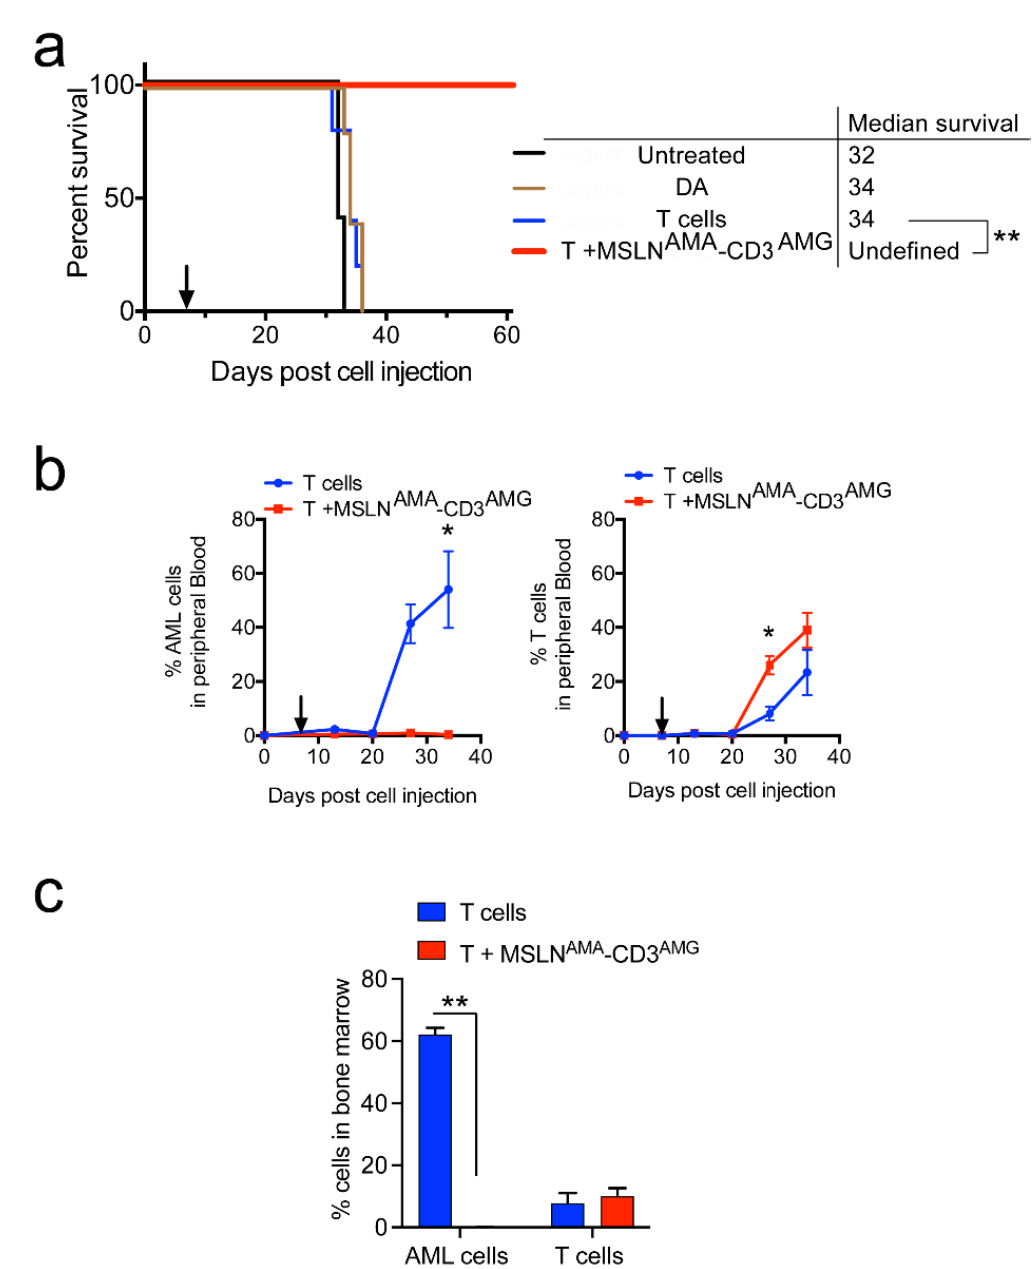
Figure 5. Confirmation of BsAb efficacy in DF-5, a refractory PDX model with MSLN positivity. ( a ) Kaplan–Meier survival plot showing the median survival. n = 5 per group, ** p < 0.005. ( b ) Graphs show the percentages of AML and T cells in peripheral blood over time. Error bars denote SE of the Mean. * p < 0.05. In ( a , b ), arrows indicate time when treatment commenced. ( c ) The terminal bone marrow AML (CD45+CD3 − ) and T cell (CD45+CD3+) percentages upon euthanasia on days 31–36 in mice receiving T cells (when they met experimental endpoint) and in day 61 mice treated with T + MSLN AMA -CD3 AMG (experiment termination), ** p <